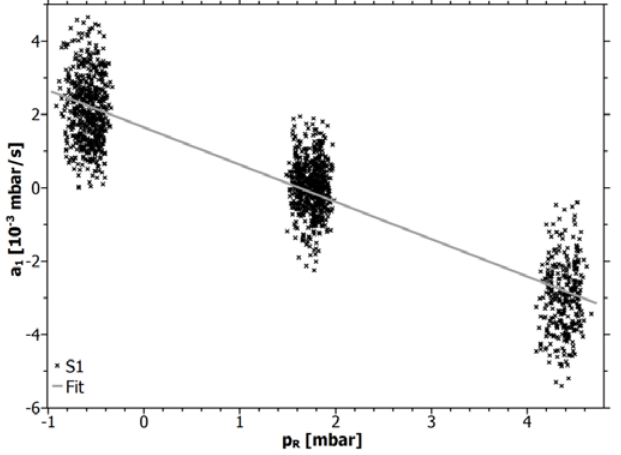
Figure 2. Influence of the pressure offset on the pressure change for line-sensor